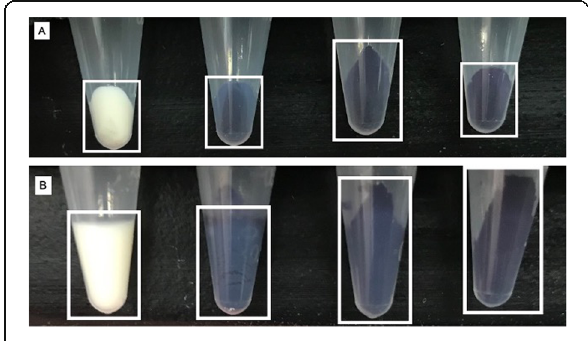
Fig. 9 Image depicting the precipitated fractions (highlighted in boxes) of centrifuged 5x-diluted dispersions with 1.25 protein:sucrose and 1.5% PP with WPI (Left), SPI (Center), and PPI (Right)